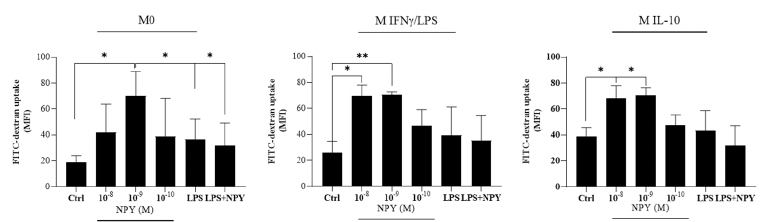
Figure 4. Flow cytometric analysis of endocytosis of FITC-dextran in M0 and polarized M(IFN- γ /LPS) and M(IL-10) macrophages stimulated with different concentrations (10 − 8 –10 − 10 M) of NPY in the presence or absence of microbial LPS. After 24 h, treated and untreated cells (1 × 10 6 cells/mL) were incubated with FITC-dextran (1 mg/mL) for 45 min. The cellular uptake was then analyzed by flow cytometry. Results are expressed as mean fluorescence intensity (MFI) (mean ± SD; N = 4). Significance was determined by one-way ANOVA followed by Tukey’s post hoc analysis; *: p < 0.05, **: p < 0.01.